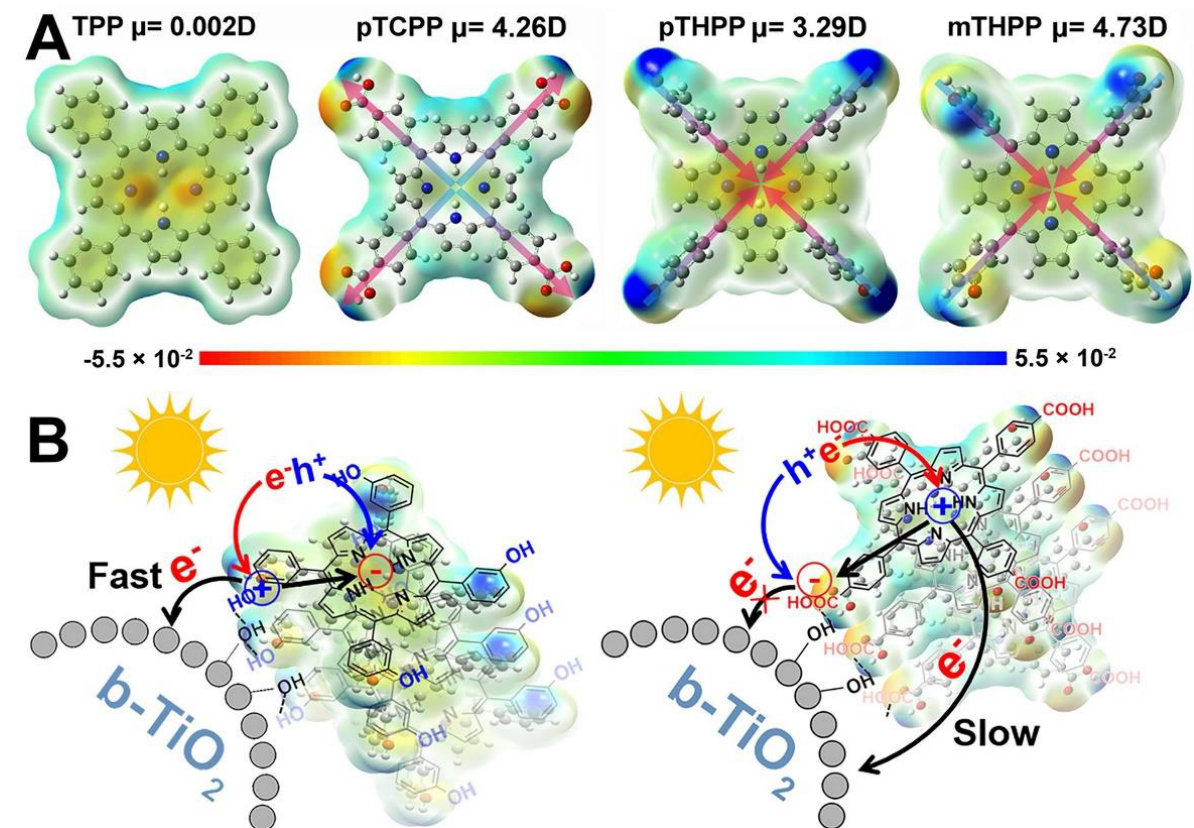
Figure 28. ( a ) Electron distribution and molecular dipoles in the four porphyrins studied (the direction of the arrow represents the direction of the built-in electric field); ( b ) illustration of charge transfer for b-TiO 2 /29mTHPP (left) and b-TiO 2 /29pTCPP (right) under light. Reproduced from reference [104] with permission from Elsevier, copyright 2022.